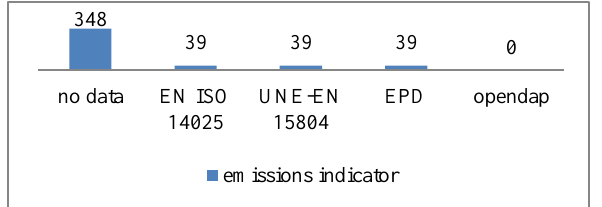
Figure 12. Semi-transparent glass components.